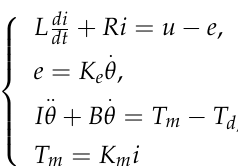
Figure 1. Schematic diagram of DDCs. The symbols in Figure 1 are defined as follows: L is the armature inductance of the motor, R is the armature resistance, i is the armature current, u is the armature voltage, e is the back-electromotive force (back-EMF), I m is the moment of inertia of the motor rotor, I L is the moment of inertia of the disk, T m is the motor torque, T d is the friction disturbance torque and θ is the angular of the shaft.